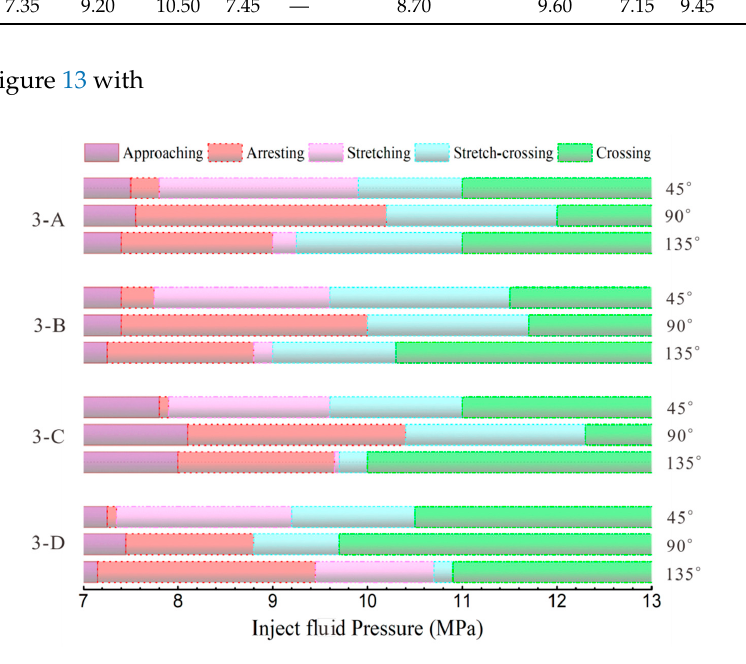
Figure 13. Fluid pressure zones for different interaction modes.